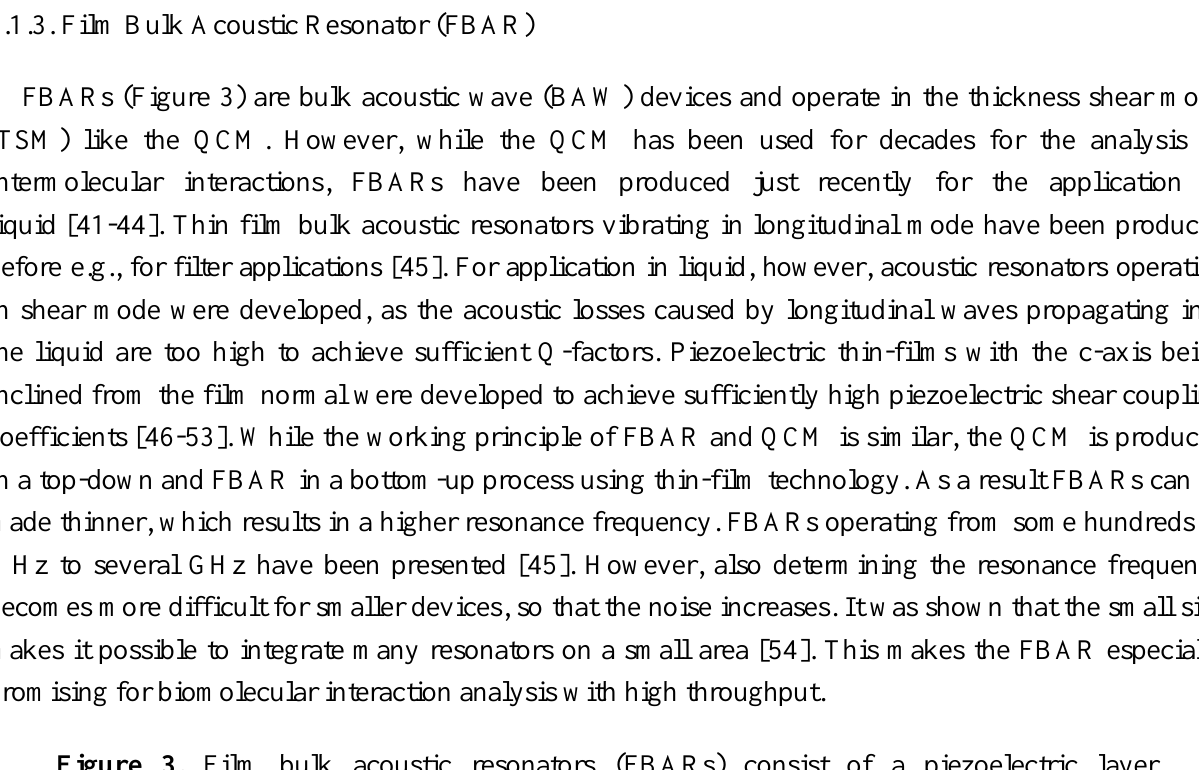
Figure 3. Film bulk acoustic resonators (FBARs) consist of a piezoelectric layer sandwiched between two electrodes over which the piezo layer is acoustically excited. The FBAR is isolated from the substrate by ( a ) an air gap or ( b ) an acoustic mirror. Reprinted from [55] and [56] with permission from